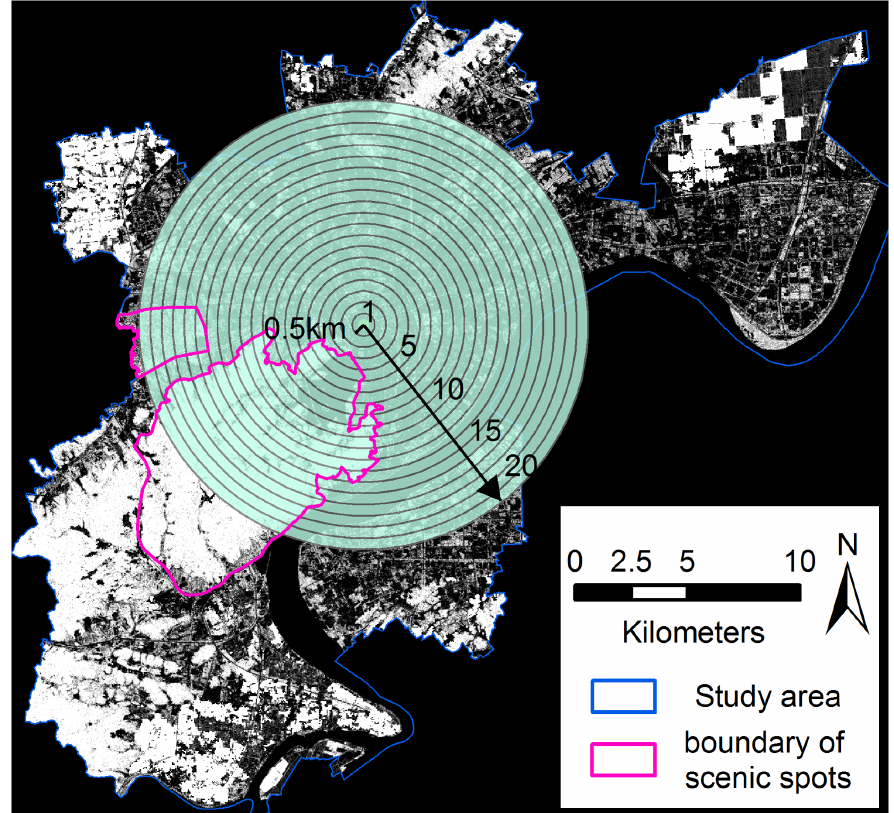
Figure 3. The layout of the concentric belts. Twenty concentric belts radiating from the city center, where each belt spans 0.5 km.